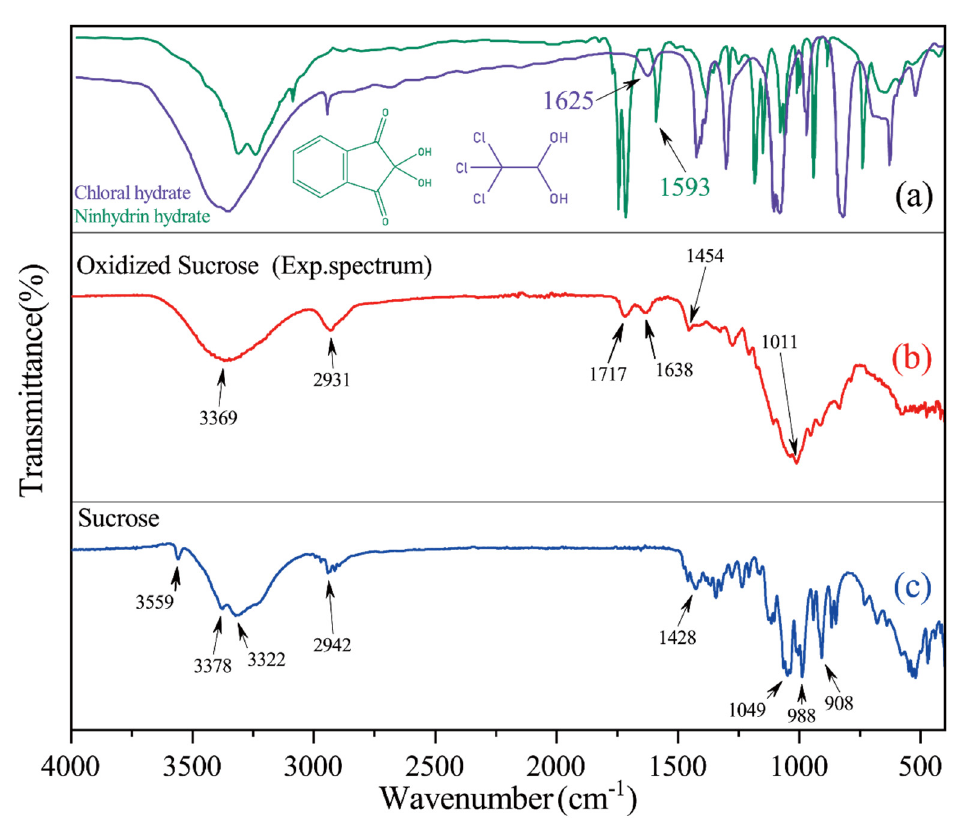
Figure 7. FTIR spectra of sucrose and OS(B) ( b ), sucrose ( c ), chloral hydrate and ninhydrin hydrate ( a ). Note: The chloral hydrate and ninhydrin hydrate spectra were obtained from the Spectral Database for Organic Compounds SDBS.